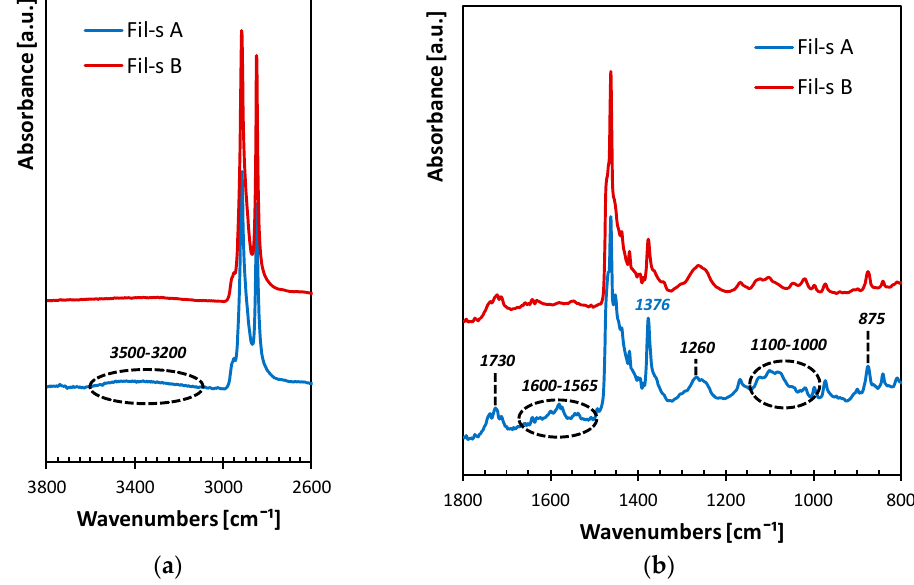
Figure 2. ATR-FTIR spectra for the lots of Fil-s analyzed in the wavenumbers intervals 3800 – 2600 ( a ) and 1800 – 800 ( b ). DSC plots for Fil-s A and Fil-s B show a first multiple peak (T m PE,1 ≅ 110 °C and T m PE,2 ≅ 124 °C), representative of the PE fraction, and a less pronounced one at a higher temper- ature (T m PP ≅ 161 °C), corresponding to the PP component. In particular, the relative PE/PP amounts inside the several lots of Fil-s analyzed were determined using a calibration curve obtained from the thermal characterization of PE/PP model blends at different per- centages of the virgin polymers [6]. In the case of the recycled materials used in this study, the main differences that can be deduced from the thermograms are: (i) the more intense PP peak for Fil-s A, which can be correlated to a polypropylene content of about 15 wt%, compared with Fil-s B, whose PP percentage (ca. 5 wt%) was significantly lower; (ii) a more pronounced shoulder of the PE peak (T m PE,1 ) for Fil-s B respect to Fil-s A, evidencing a major fraction of polyethylene with higher branch density (short and/or long branching) [17]. The FTIR-ATR plots in Figure 2 confirm that Fil-s A contains a higher amount of PP with respect to Fil-s B, as it can be clearly deduced from the more pronounced peak at 1376 cm − 1 , assigned to the scissoring of the methyl group CH 3 . The two lots of Fil-s also differ in the intensity of the other infrared bands highlighted in Figure 2, which can be related to the presence of polar contaminants, such as polyamide and polyester traces [6]. The assignments for these peaks are summarized in Table 3. Table 3. FTIR signals and vibrational assignments for Fil-s. Wavenumbers (cm − 1 )